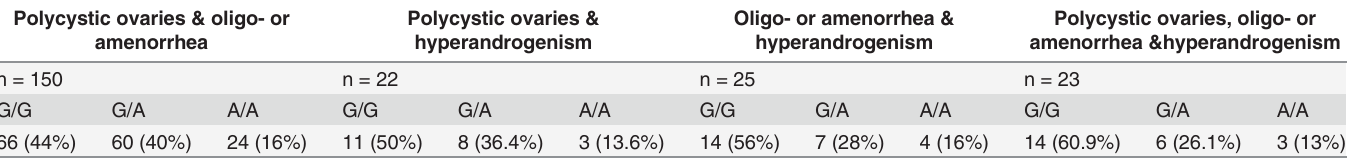
Table 2. Clinical features of women with polycystic ovary syndrome (PCOS) according to the genotypes.